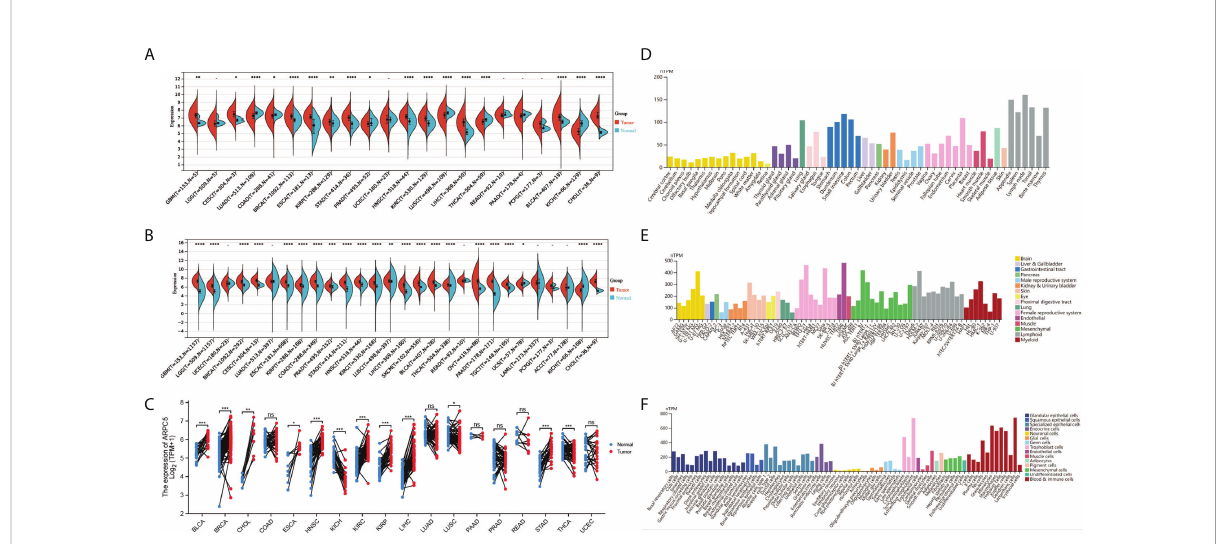
FIGURE 1 The expression levels of APRC5 in different cancers, normal tissues, and cells. (A) The differential expression of ARPC5 in pan-cancer tissues from TCGA datasets. (B) The differential expression of ARPC5 in pan-cancer tissues based on TCGA and GTEx datasets. (C) ARPC5 expression in paired cancer tissues and adjacent normal tissues from TCGA datasets. (D) The mRNA expression levels of ARPC5 in different normal tissues from HPA database. (E) The mRNA expression of ARPC5 in cancer cell lines from HPA database. (F) ARPC5 mRNA expression in different single cell types from HPA database. ns: no signi fi cance; * p < 0.05; ** p < 0.01; *** p < 0.001; **** p <